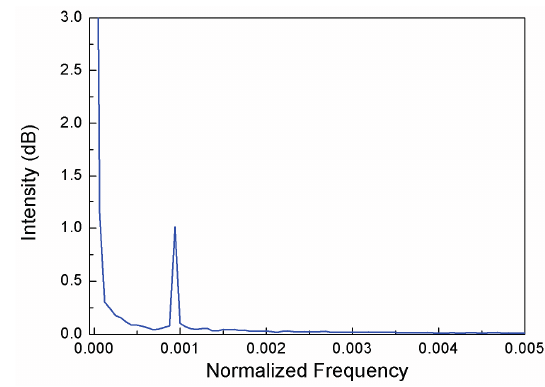
Figure 3. FFT results of the reflective spectrum of the